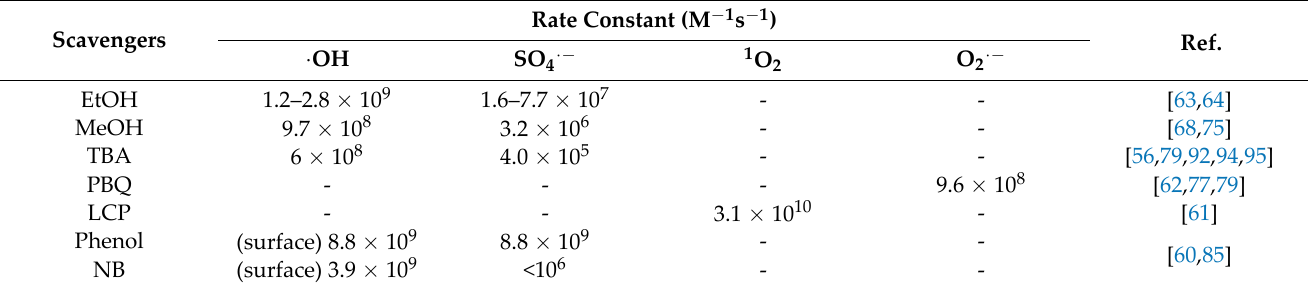
Table 4. The second‑order reaction constants of commonly used quenchers to